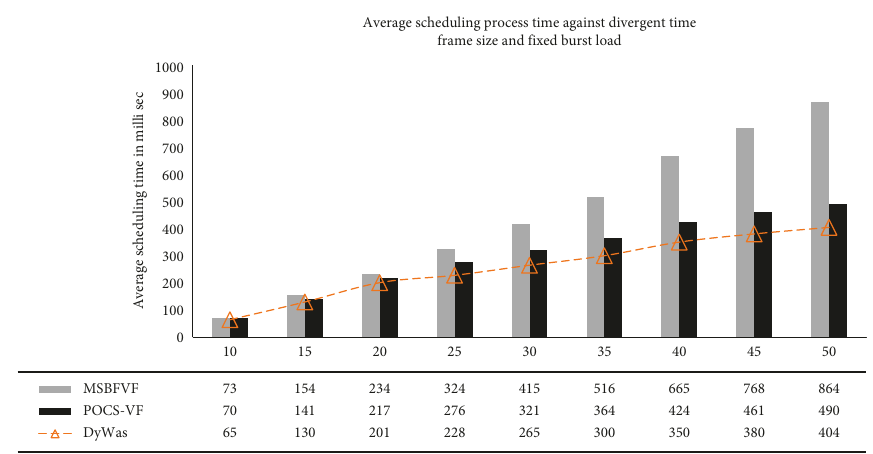
Figure 6: Average time depiction for scheduling of bursts: diversified sizes of timeframes and constant 35680 bytes of burst